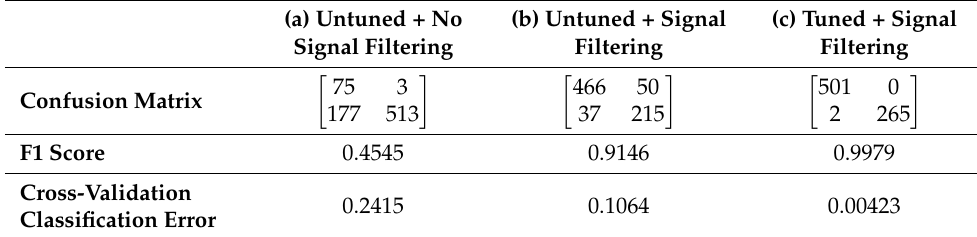
Figure 17. q angular rate in the body axis for the elevator actuator 50% LOE fault with ( a ) no noise and the same variable with ( b ) Gaussian white noise. Table 8. SVM elevator actuator model results for Gaussian white noise with SNR of 20